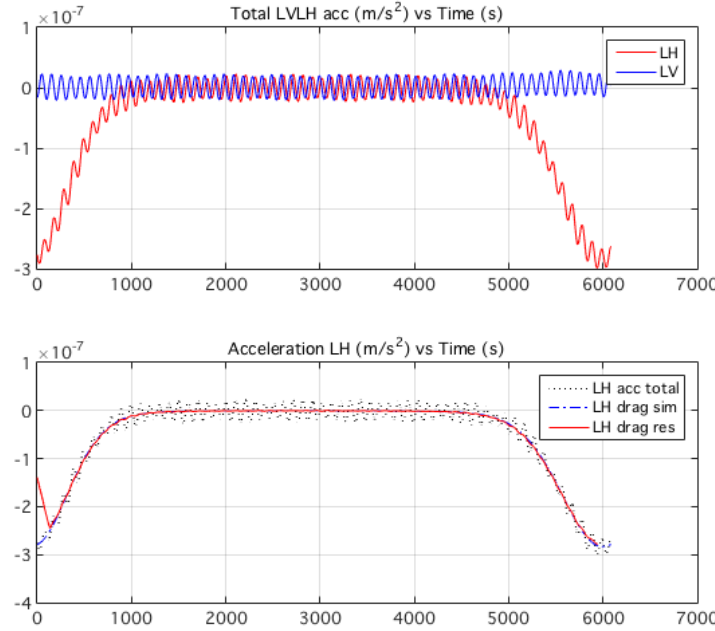
Figure 5. ( Top ) Total acceleration components in the LV-LH frame; ( bottom ) total acceleration along LH, simulated LH drag acceleration component (labeled “LH drag sim”) and resolved LH drag acceleration (labeled “LH drag res”) over one